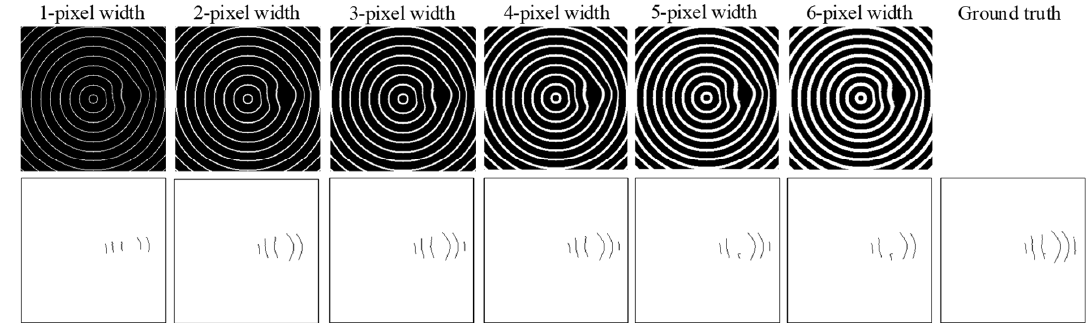
Fig. 8. The defective captured images and their corresponding resulting images of distortion flaw inspection by the proposed method for producing the concentric circles with various line